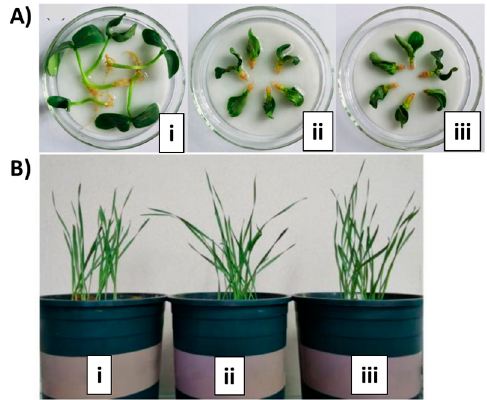
Figure 7. Bioactivity for the target cucumber plant ( A ) and non-target wheat plant ( B ), involving a study with carboxymethyl chitosan for controlled release of pesticides; control with deionized water (i), free pesticide (ii), and pesticide-loaded micelles (iii). Adapted from a previously reported work